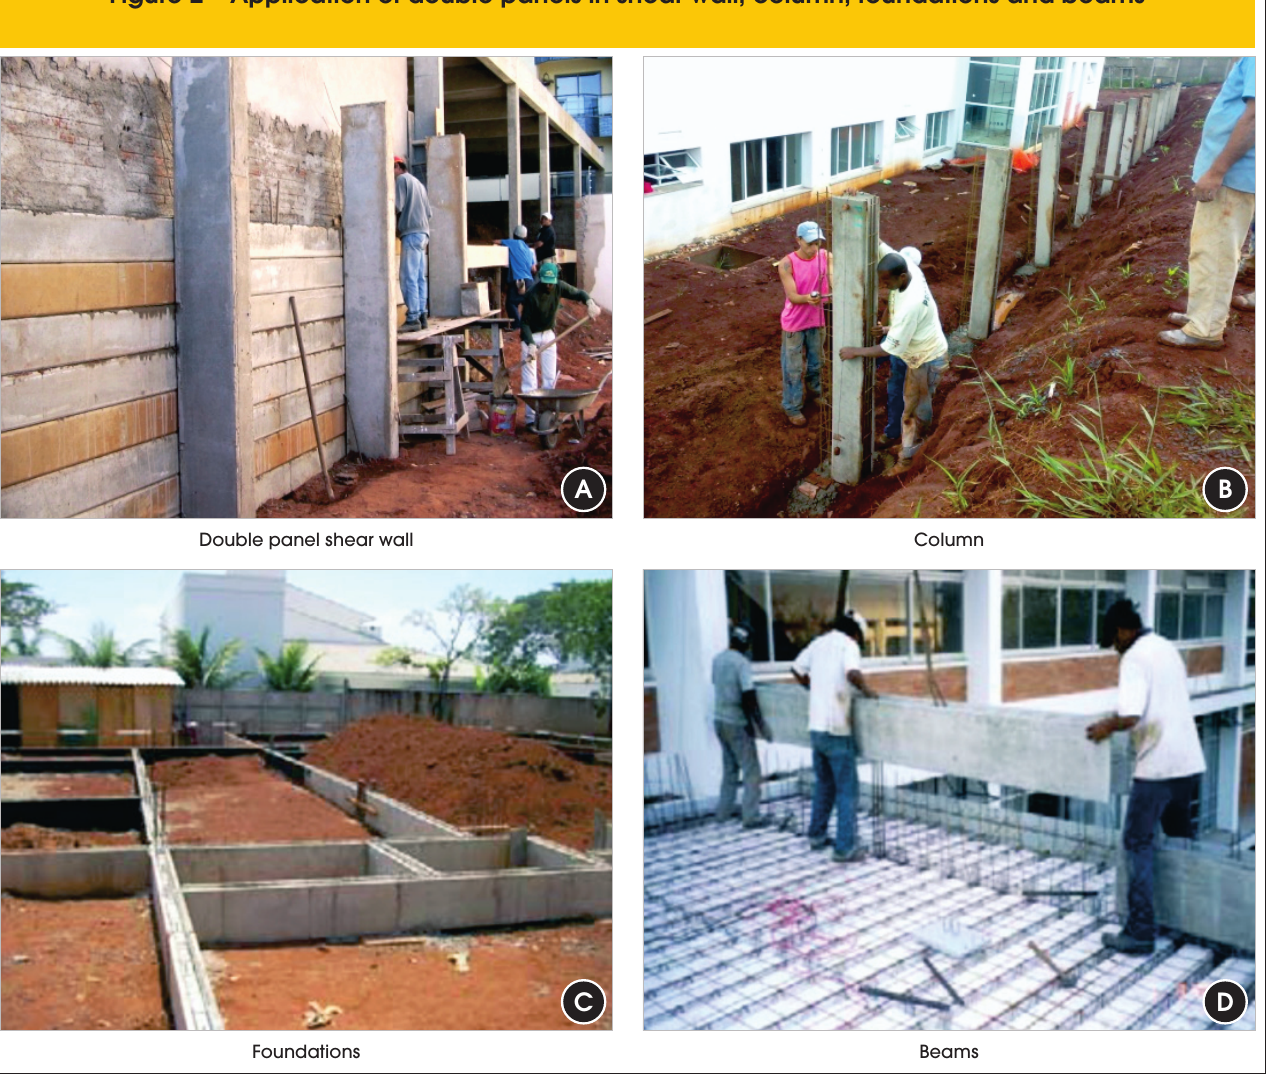
Figure 2 – Application of double panels in shear wall, column, foundations and